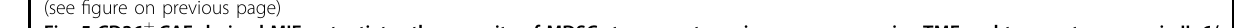
Fig. 5 CD36 + CAF-derived MIF potentiates the capacity of MDSCs to promote an immunosuppressive TME and tumor stemness via IL-6/ STAT3 activation. a The schematic diagram showed co-culture of MDSCs precursors with condition media (CM) of CD36 + CAFs, CD36 – CAFs, CD36 kd CAFs, CD36 + CAFs + ISO-1 or blocking CD74. b , c MDSC proportion was measured by fl ow cytometry when co-cultured with vehicle Ctrl, CD36 + CAFs, CD36 – CAFs, CD36 kd CAFs, a combination of CD36 + CAFs and MIF inhibitor ISO-1, or a combination of CD36 + CAFs and CD74 blocking agents. d The schematic diagram showed co-injection of tumor cells and CD36 + CAFs at the ratio of 30:1 in orthotopic HCC model. e Representative images of HCC tumors from the orthotopic HCC model. f Liver weight, tumor numbers, tumor volume and ratio of liver weight and mice weight from the orthotopic HCC model. CAFs transduced with the empty lentiviral vector as a control. g The proportion of effector CD8 + T cells from different groups in the orthotopic HCC model. h The western blot and ELISA assays showed iNOS was evaluated in MDSCs-WT, CD36 + CAFs + MDSCs, a combination of CD36 + CAFs + MDSCs and ISO-1 or α Gr-1. i , j The proportion of CD69 + CD8 + T cells was evaluated in MDSCs-WT, CD36 + CAFs + MDSCs, a combination of CD36 + CAFs + MDSCs and ISO-1 or blocking CD74 by fl ow cytometry. k , l GSEA and KEGG analysis shows top pathways enriched in MDSC-CD36 + CAF-CM vs MDSC-WT. m Western blotting experiment shows NF-kB pathway changes in MDSCs treating with CD36 + CAFs. n ELISA assay shows IL-6 secretion in MDSCs treating with CD36 + CAFs, CD36 kd CAFs, MIF or a combination of MIF and ISO-1. Data shown as mean ± S.E.M., one-way ANOVA following multiple comparison test was used, *** P < 0.001, ** P < 0.01, * P < 0.05, and ns not signi fi